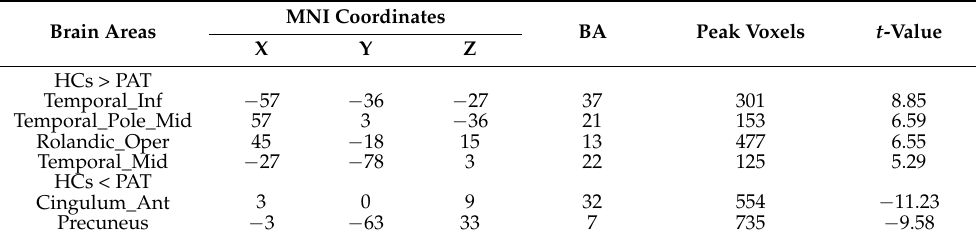
Table 2. Brain regions presented alteration VMHC value with statistical